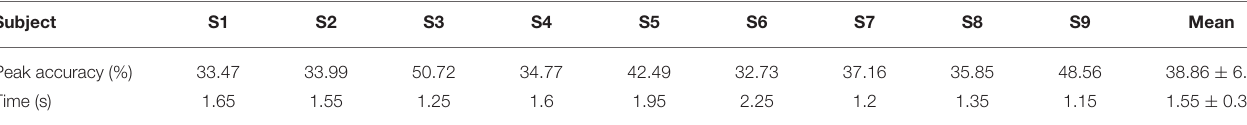
TABLE 3 | Multiclassification performance, subject-specific peak accuracies over all subjects, and time of occurrence (s) with respect to the movement